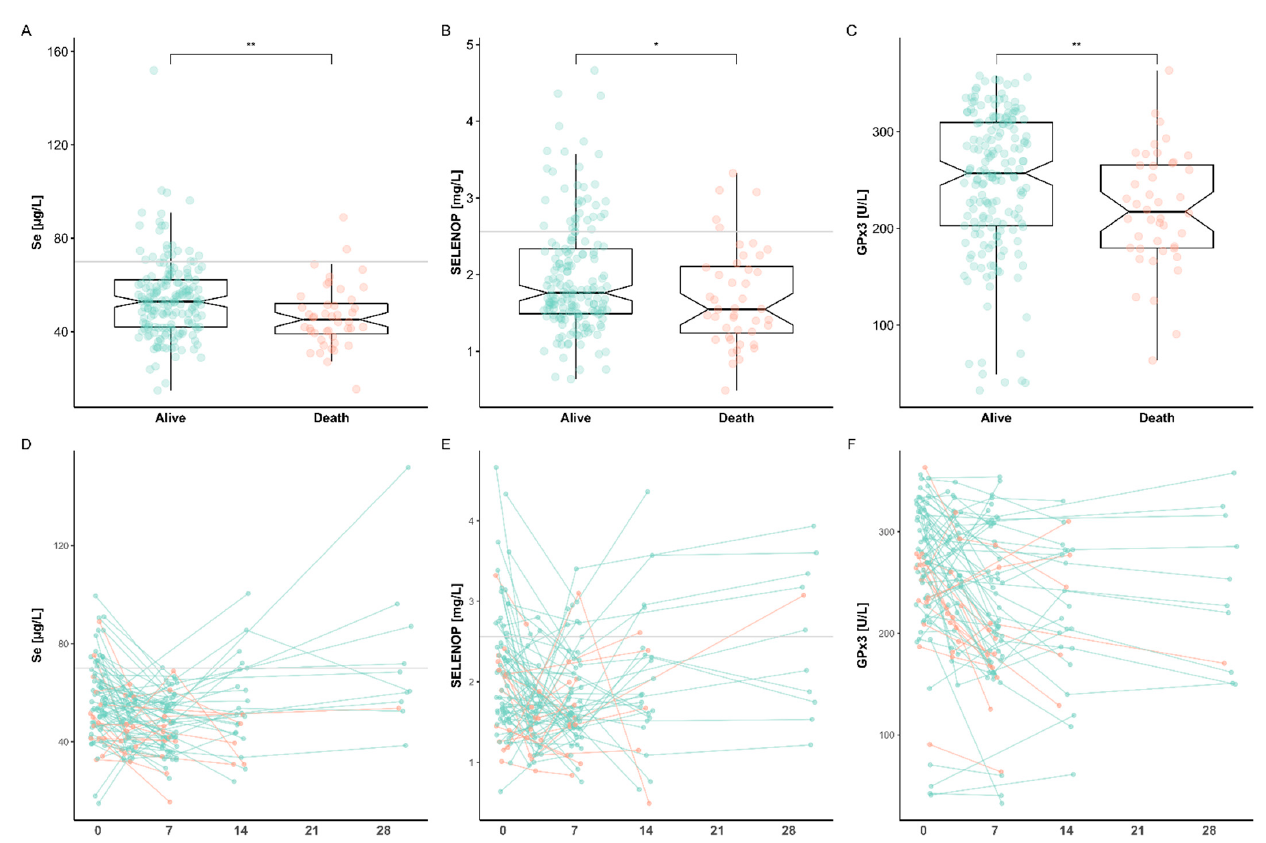
Figure 4. Comparison of Se status biomarkers in relation to survival. Patients undergoing liver transplantation (LT) were separated into survivors (Alive) and non-survivors (Death). Non-survivors displayed significantly reduced ( A ) serum Se, ( B ) SELENOP and ( C ) GPx3 levels as compared to survivors. A time resolved analysis of the individual patients ( D – F ) revealed consistently reduced concentrations of all three biomarkers in the majority of samples from postoperative day 0 (POD 0) to POD 7, and until POD 30. A general tendency of recovering Se status with time after surgery is noted in the majority of surviving patients, and in a minority of the non-survivors. Comparisons by Mann–Whitney U test; * p < 0.05, and ** p < 0.01.